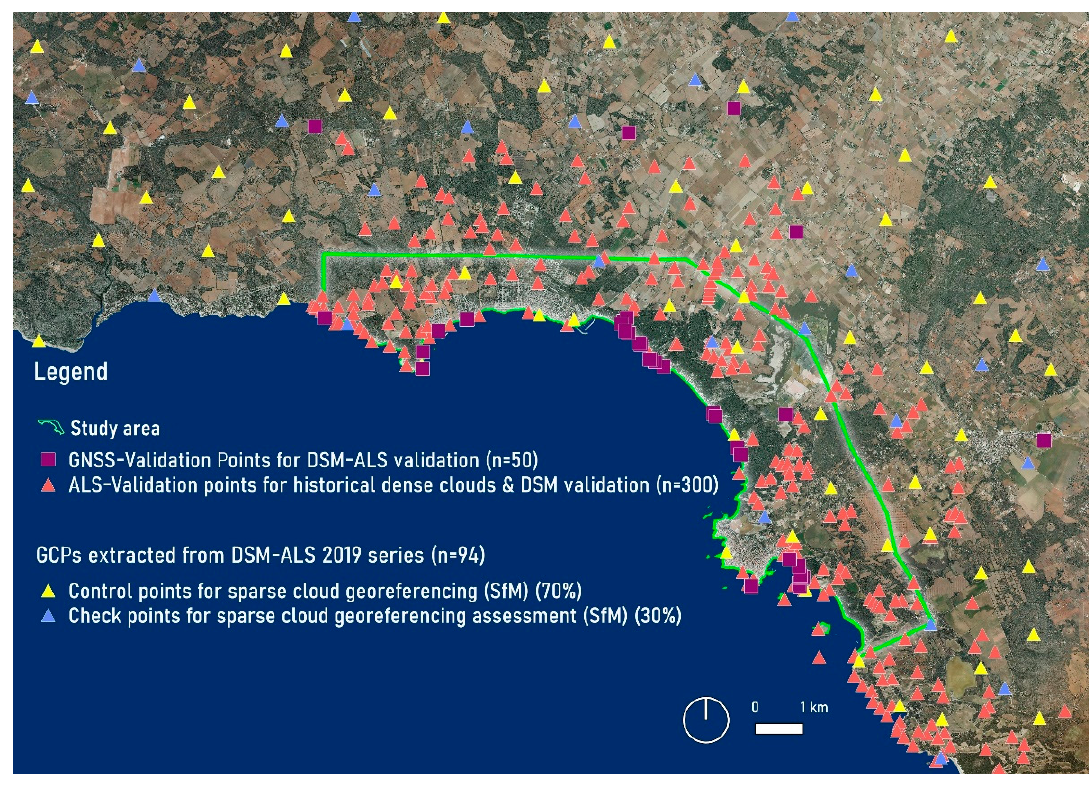
Figure 3. Distribution of the GNSS-Validation Points, Control Points, Check Points, and ALS- Validation Points used in the study.